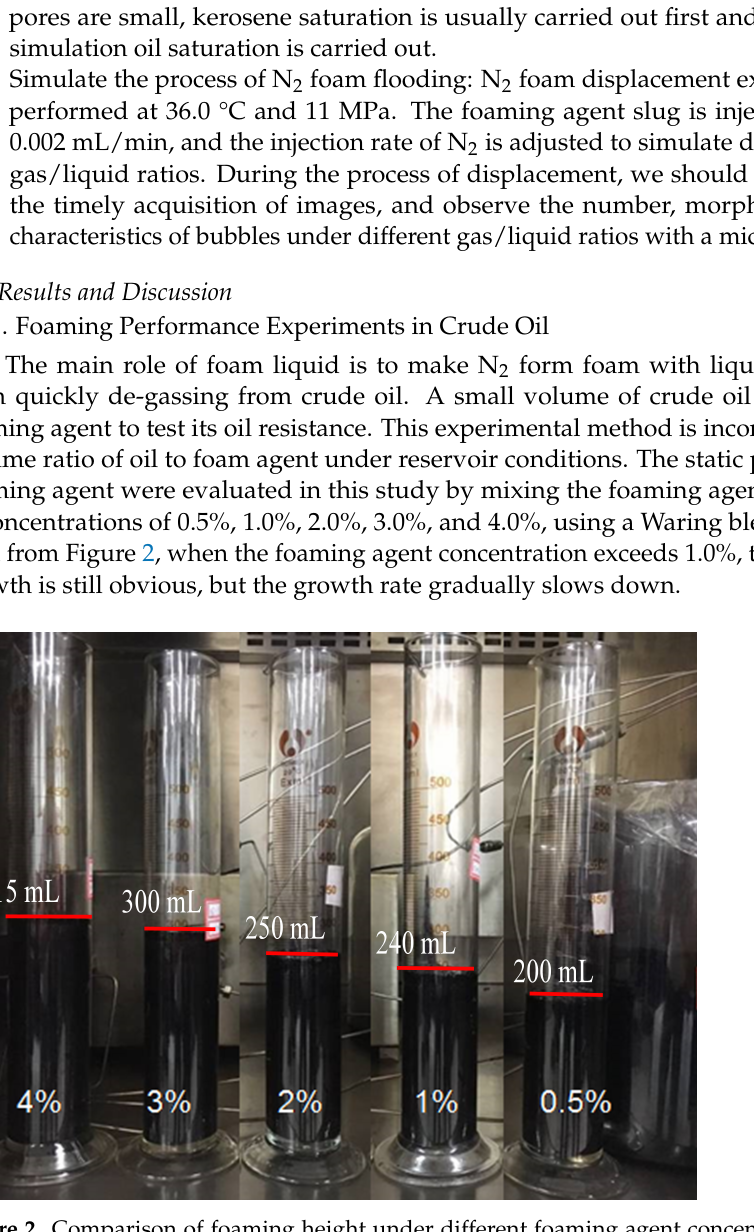
Figure 2. Comparison of foaming height under different foaming agent concentrations (foaming agent and crude oil at a 1:1